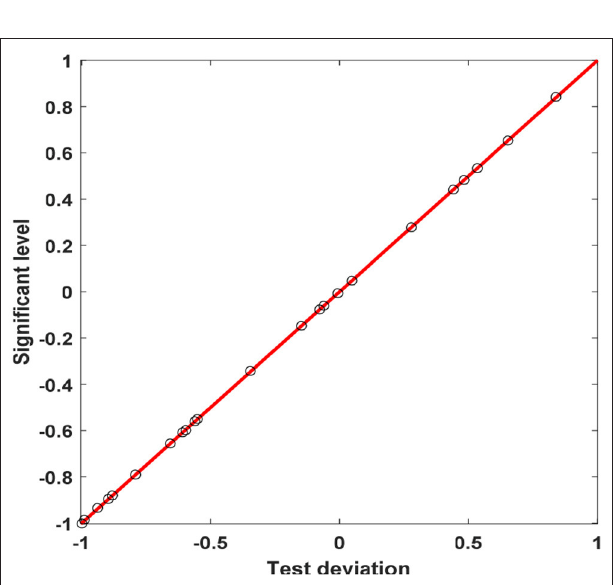
FIGURE 7 | Significance level distribution of cognitive ability test of left-behind children.